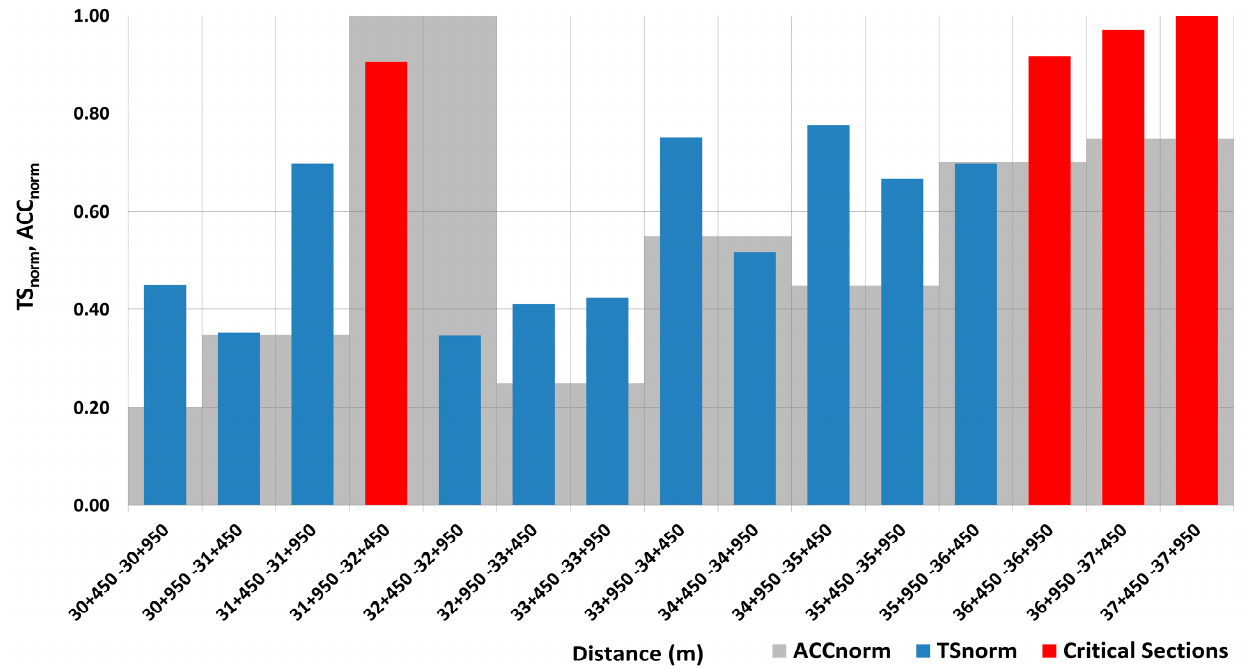
Figure 6. Comparison between the outcomes of the inspection assessments and the historical accident rate.